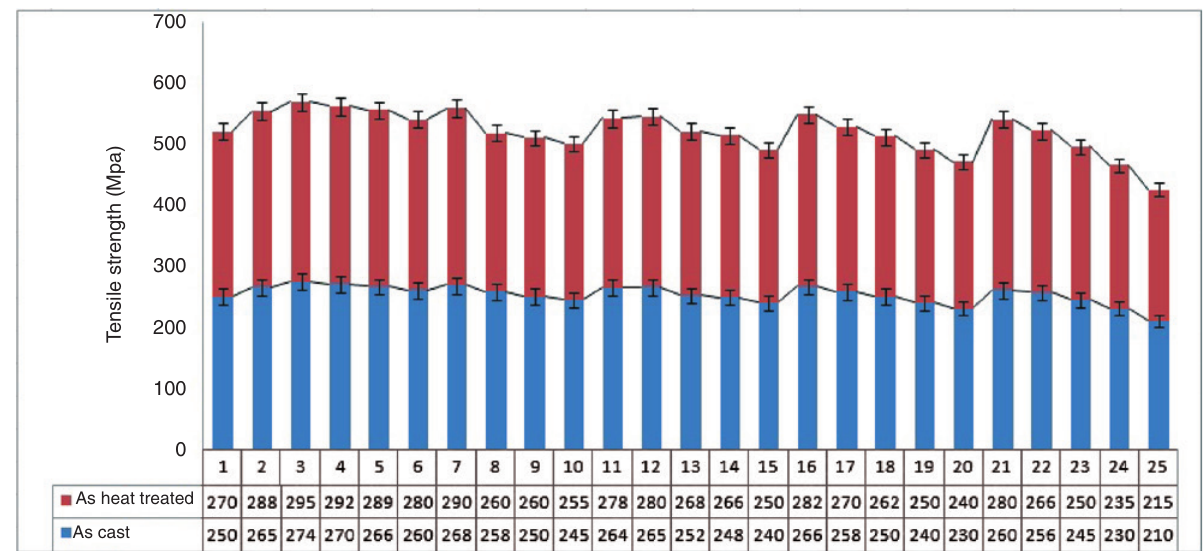
Figure 2: Tensile strength of hybrid green